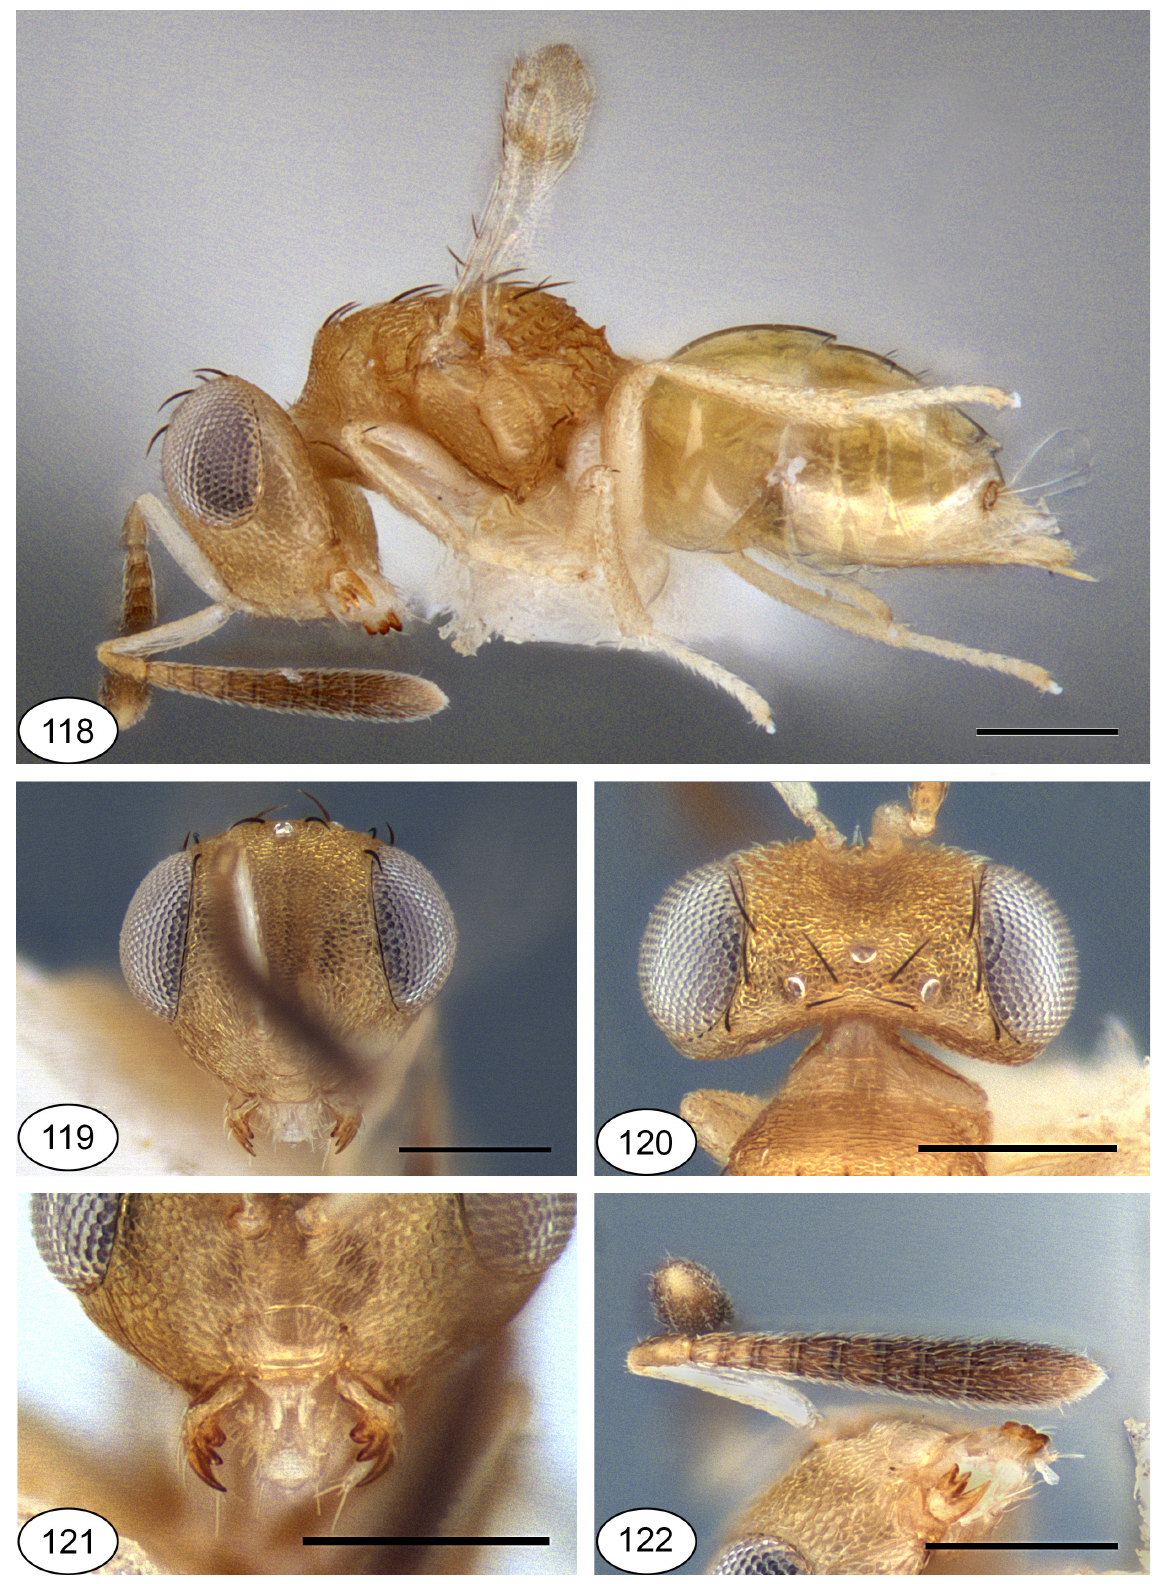
Figs 118–122. Netomocera meridionalis sp. nov., holotype, ♀ . 118 . Habitus, lateral view. 119 . Head, frontal view. 120 . Head, dorsal view. 121 . Lower face. 122 . Antenna. Scale bars: 0.2